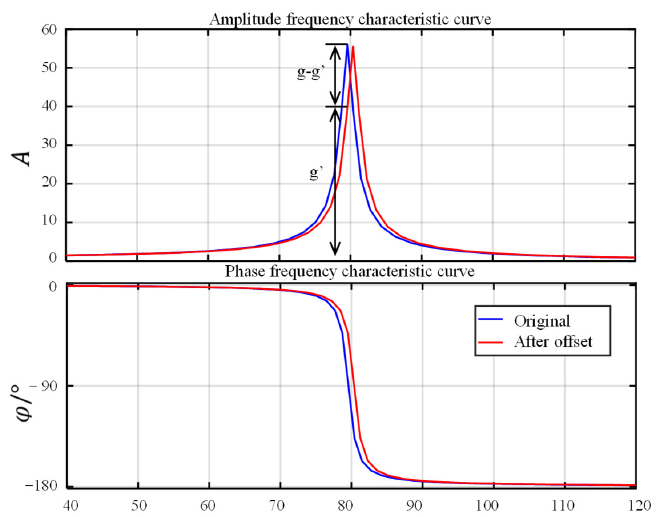
Figure 14. Schematic diagram of gain drop.